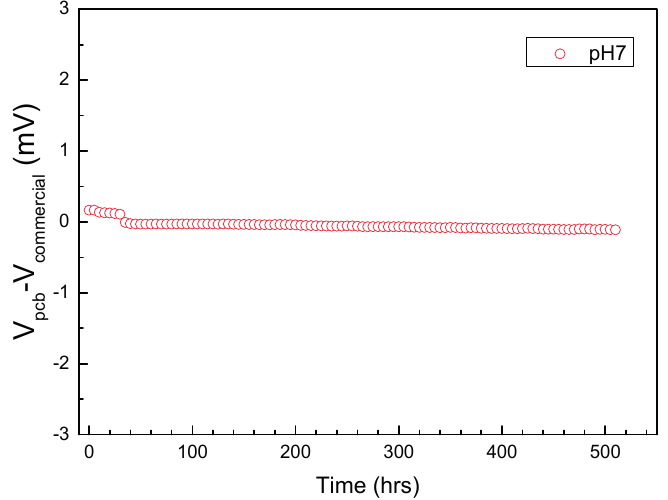
Figure 6. Voltage difference between PCB (Printed Circuit Board) pseudo-reference electrodes and commercial Ag/AgCl reference electrodes V pcb -V commercial evolution over 500 h (20 day) at neutral